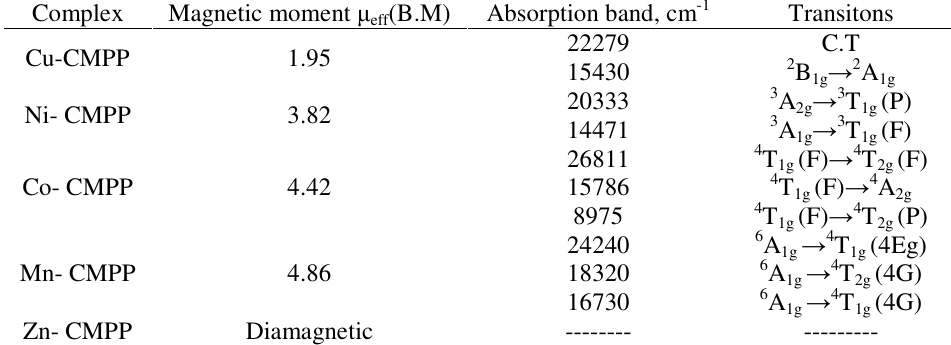
Table 2. Magnetic moment & reflectance data of the metal complexes.